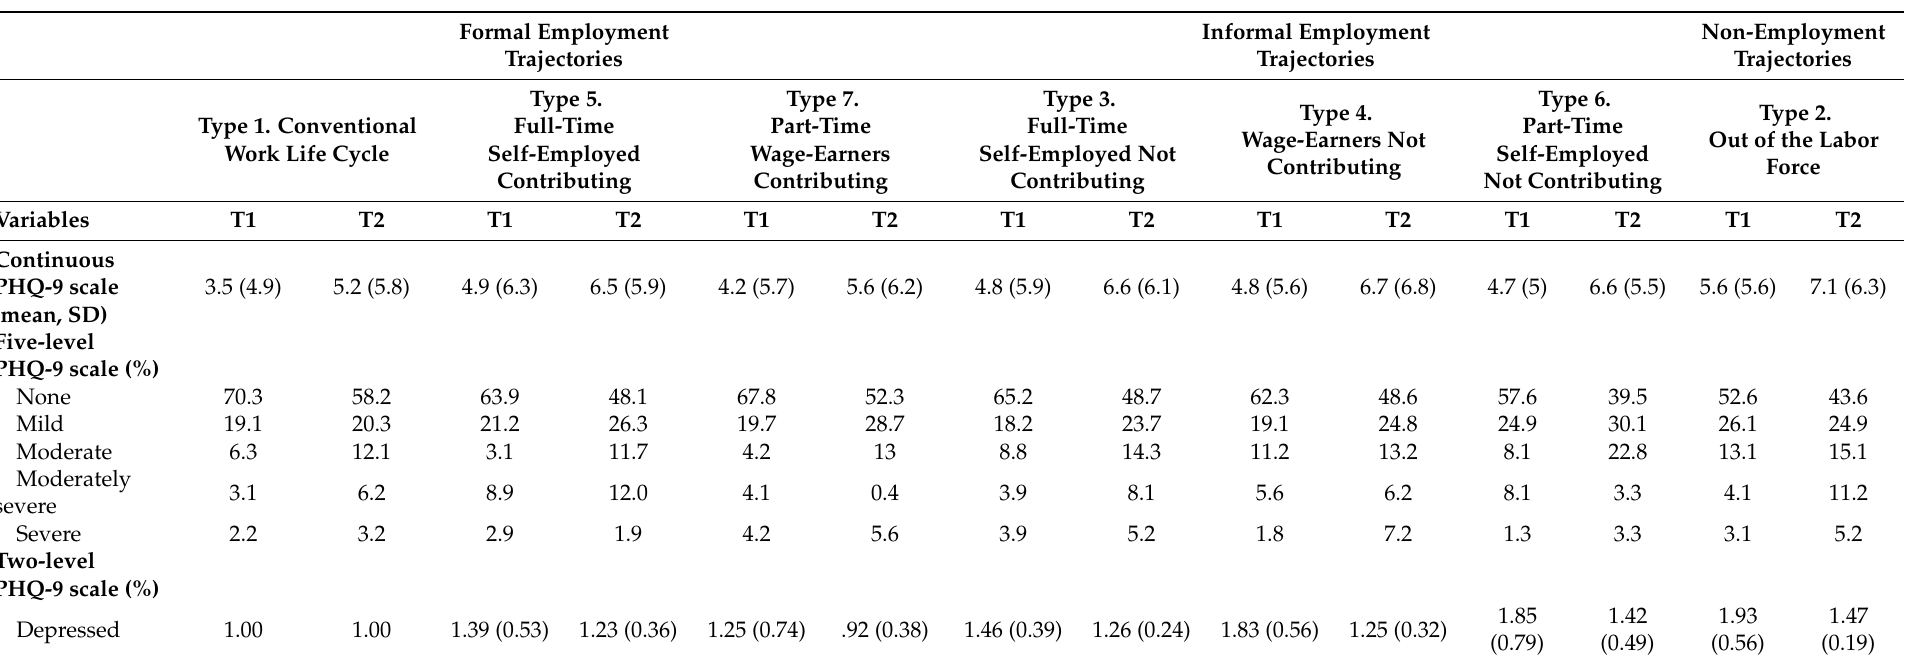
Table A2. Bivariate associations between employment trajectories and mental health outcomes before and after the onset of the COVID-19